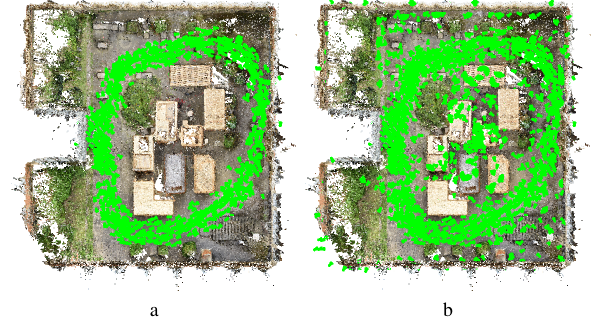
Figure 3. Poses of training images of the Diverge data set (a) and the Real-Diverge data set (b) for the medium coverage sqeuence (depicted in green) visualized in top view of the Atrium.